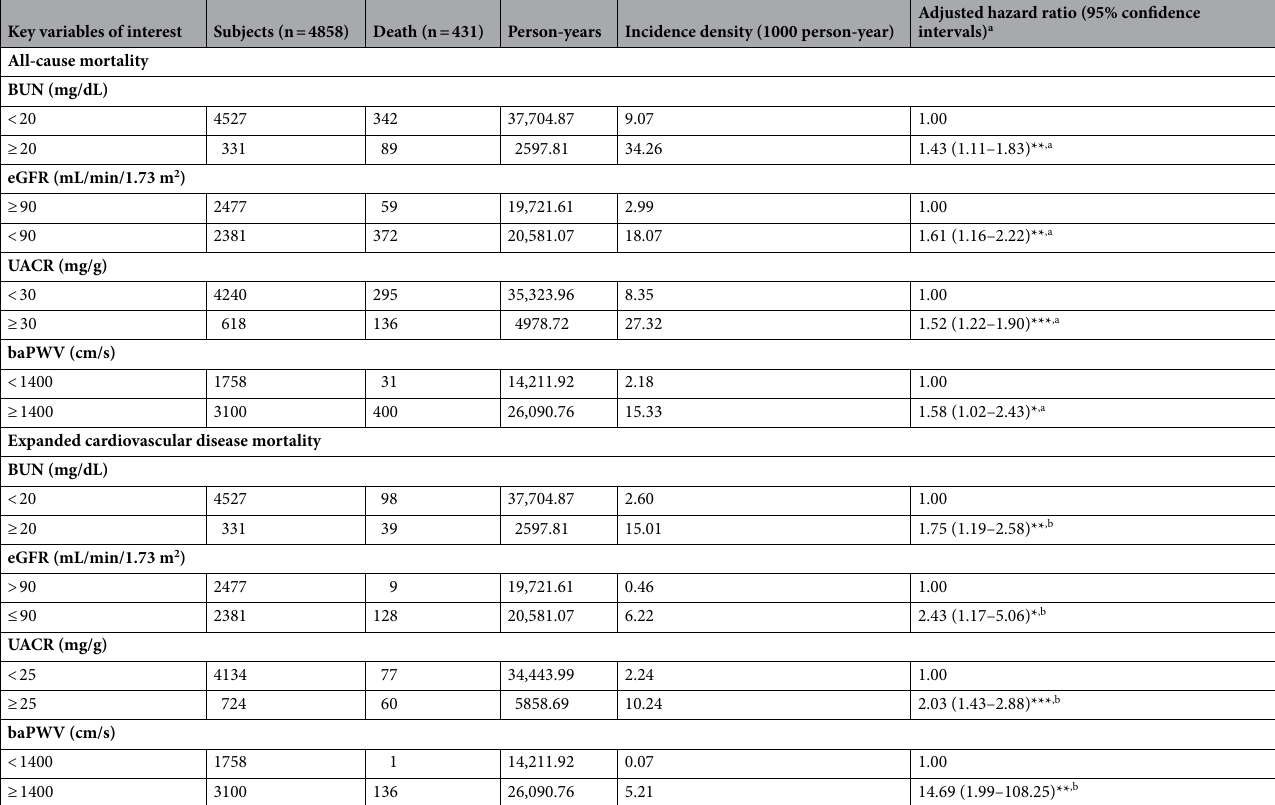
Table 3. Hazard ratios of key variables of interest for all-cause mortality from Cox proportional hazard model after excluding subjects died in the first year. HDL-C high density lipoprotein-cholesterol, BMI body mass index, MAP mean arterial pressure, BUN blood urea nitrogen, eGFR estimated glomerular filtration rate, UACR urine albumin-to-creatinine ratio, baPWV brachial-ankle pulse wave velocity. *p < 0.05; **p <